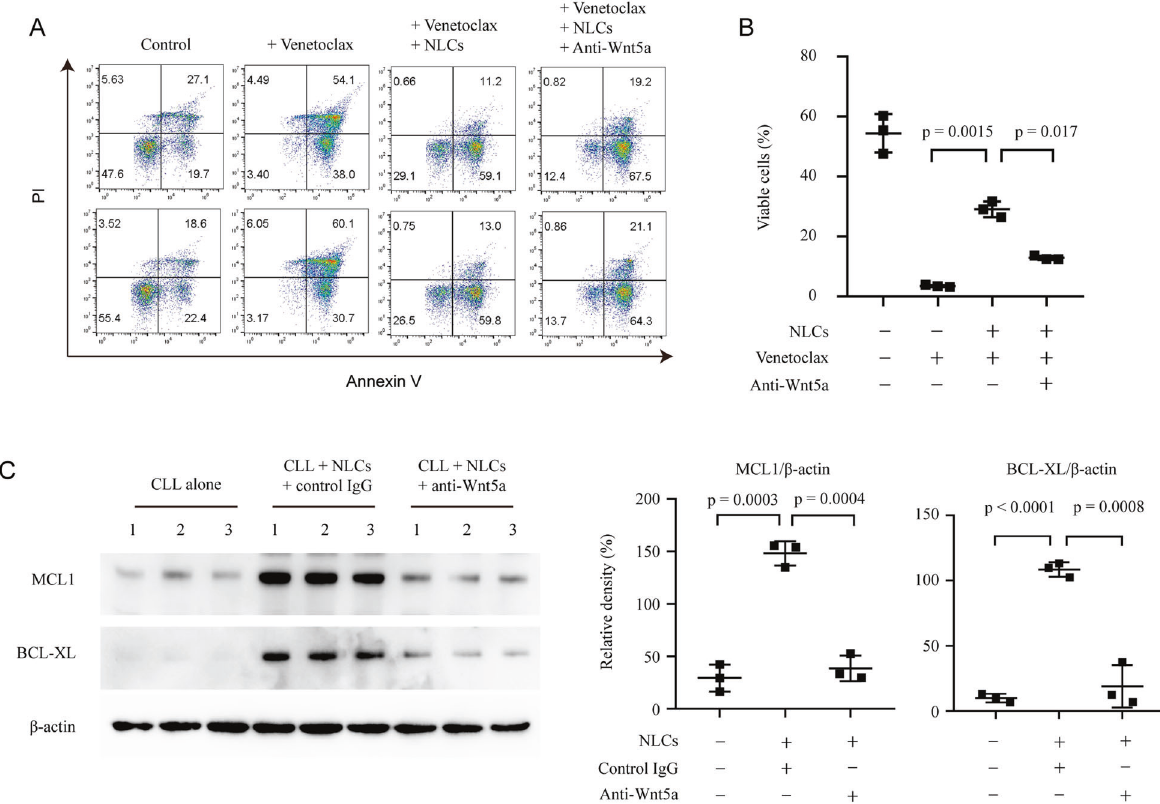
Fig. 5 NLCs upregulate MCL1 and BCL-XL in CLL cells through Wnt5a. A Flow cytometry analysis of apoptosis of CLL cells cultured with venetoclax, NLCs, and anti-Wnt5a for 24 h. Dot fi gures represent viable cells in each group ( n = 3). B Immunoblot analysis of MCL1 and BCL-XL in lysates of CLL cells with or without NLCs treated by anti-Wnt5a or control mAb of irrelevant speci fi city for 24 h. Dot fi gures represent ratios of densities (MCL1/ β -actin and BCL-XL/ β